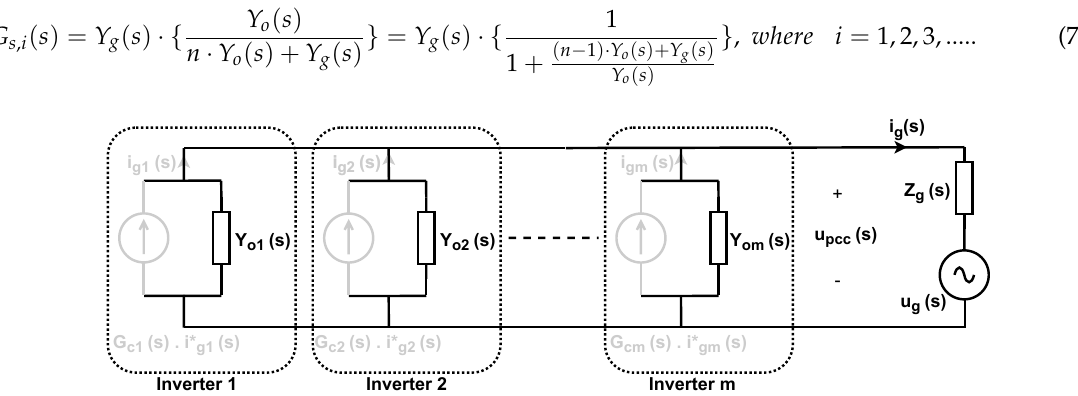
Figure 5. Equivalent admittance model for the impact of the utility grid voltage on the injected